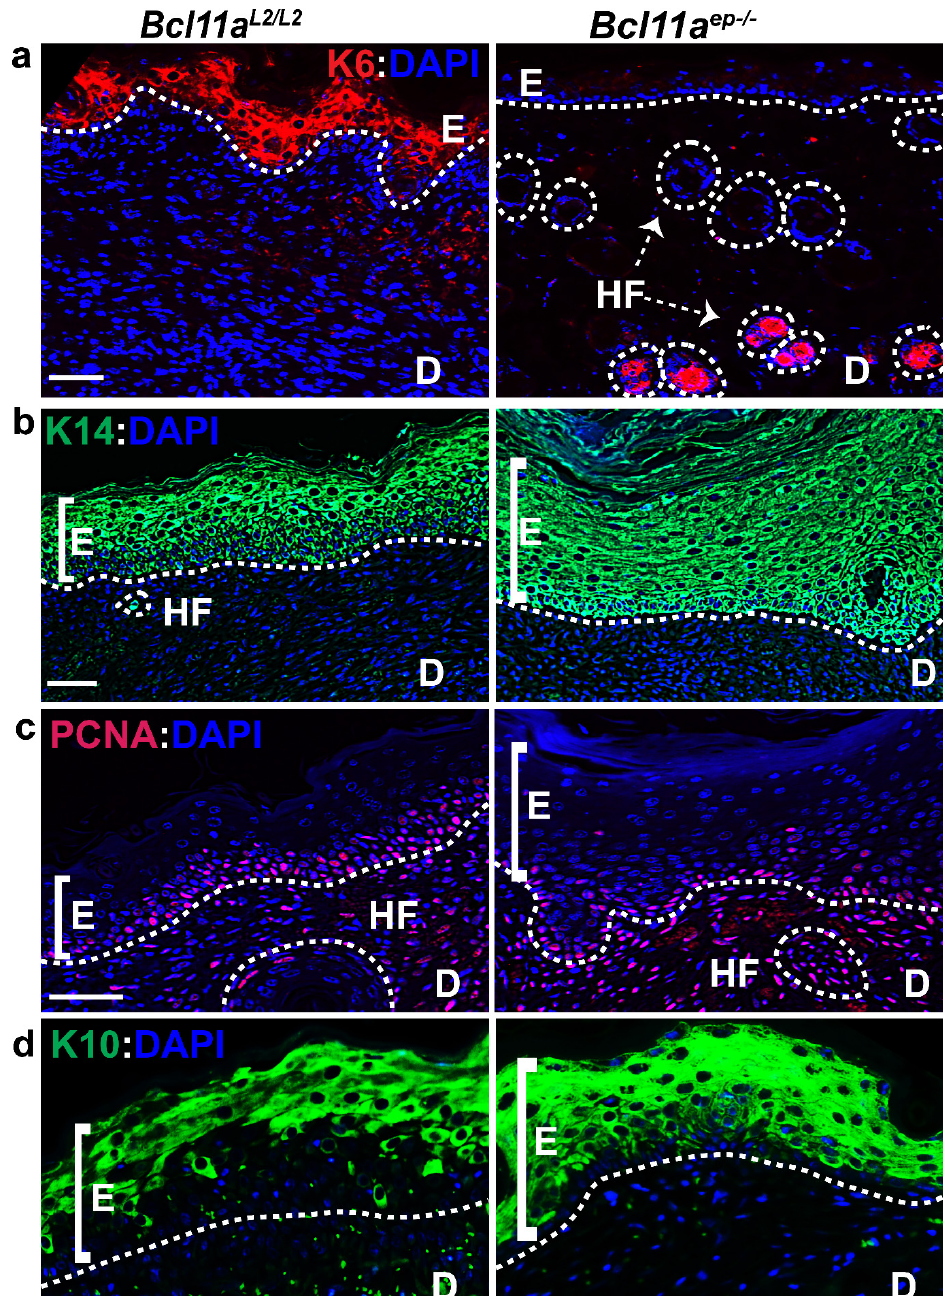
Figure 4. Cell autonomous role of epidermal specific Bcl11a ablation in promoting accelerated healing by early keratinocyte activation, re-epithelialization, and rapid onset of differentiation (Day 8). ( a – d ) IHC analysis of activated keratinocyte marker K6 (red), epidermal proliferative basal keratinocyte marker K14 (green), active proliferation marker PCNA (red), and early differentiation marker K10 (green) expression in WBAE on Day 8 post wounding samples from Bcl11a L2/L2 versus Bcl11a ep − / − mice. All sections were counterstained with DAPI (blue). White dotted lines separate E from D and outline the HFs. D—Dermis; E—Epidermis; HF—Hair follicle; WBAE—Wound Bed Adjacent Epidermis. Scale bar = 50 µ m. N = 4, where N represents the number of animals of each genotype ( Bcl11a L2/L2 or Bcl11a ep − / − ) involved in the study. Multiple fields of views (FOVs) captured per sample per genotype for statistical